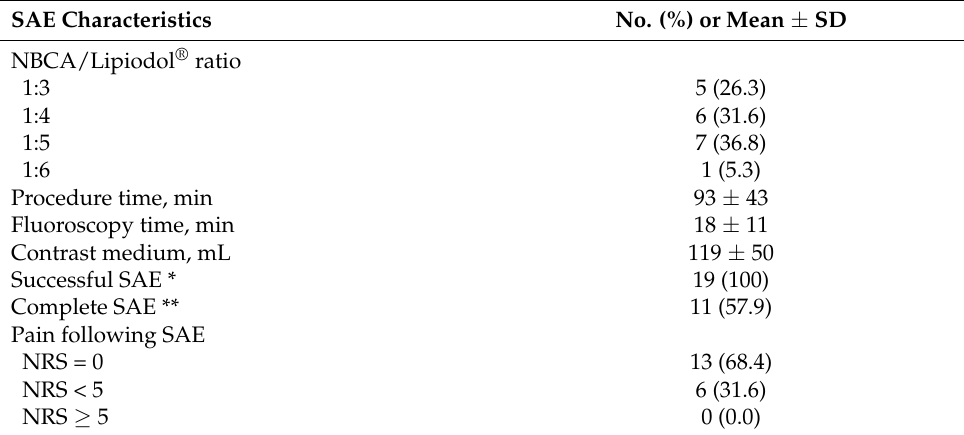
Table 3. Characteristics of the selective arterial embolization (SAE) procedures of the 20 malignant kidney tumors performed prior to percutaneous cryoablation in 19 patients. SAE